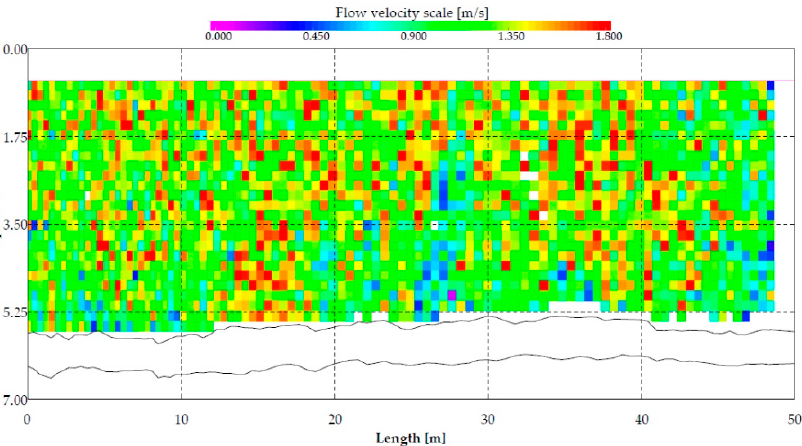
Figure 8. The subsection of the flow velocity contour profile measured with ADCP during high flows (m03), corresponding to the model’s XS-US.